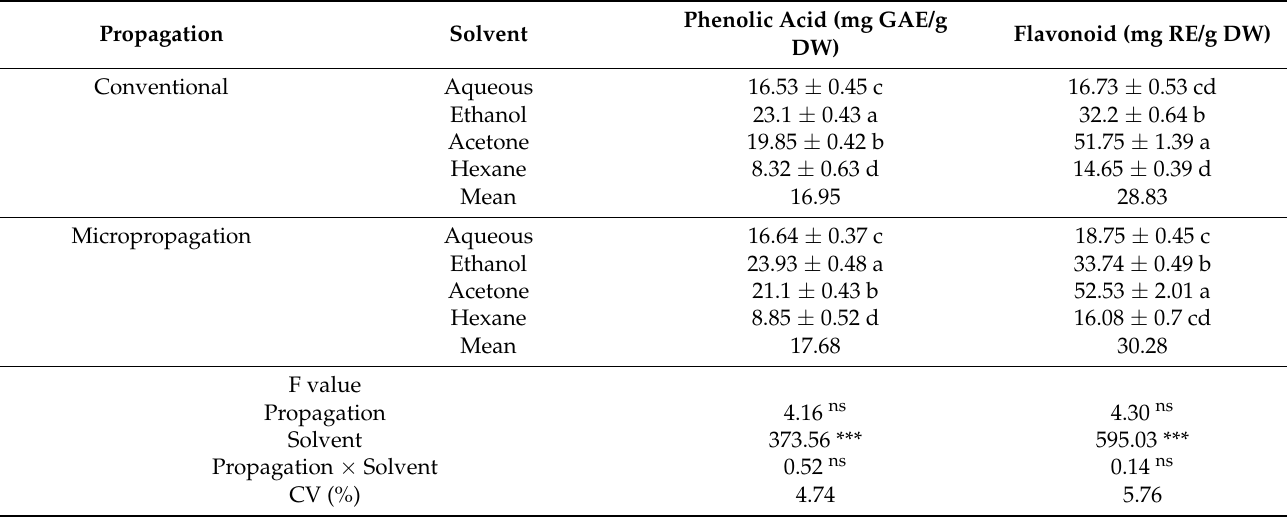
Table 6. Total phenolic acid and flavonoid content of micropropagated and conventionally propagated rhizomes of ‘Ben- tong’